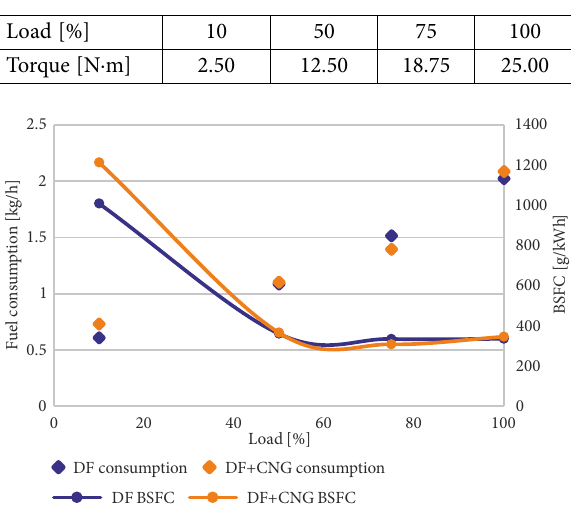
Table 3. The engine torque values at different loads